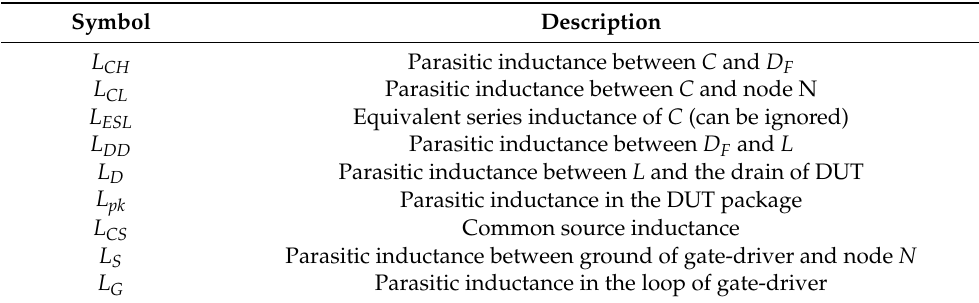
Figure 2. Equivalent circuit of DPT with parasitic inductance. Table 1. Description of various parasitic inductance components in Figure 1.